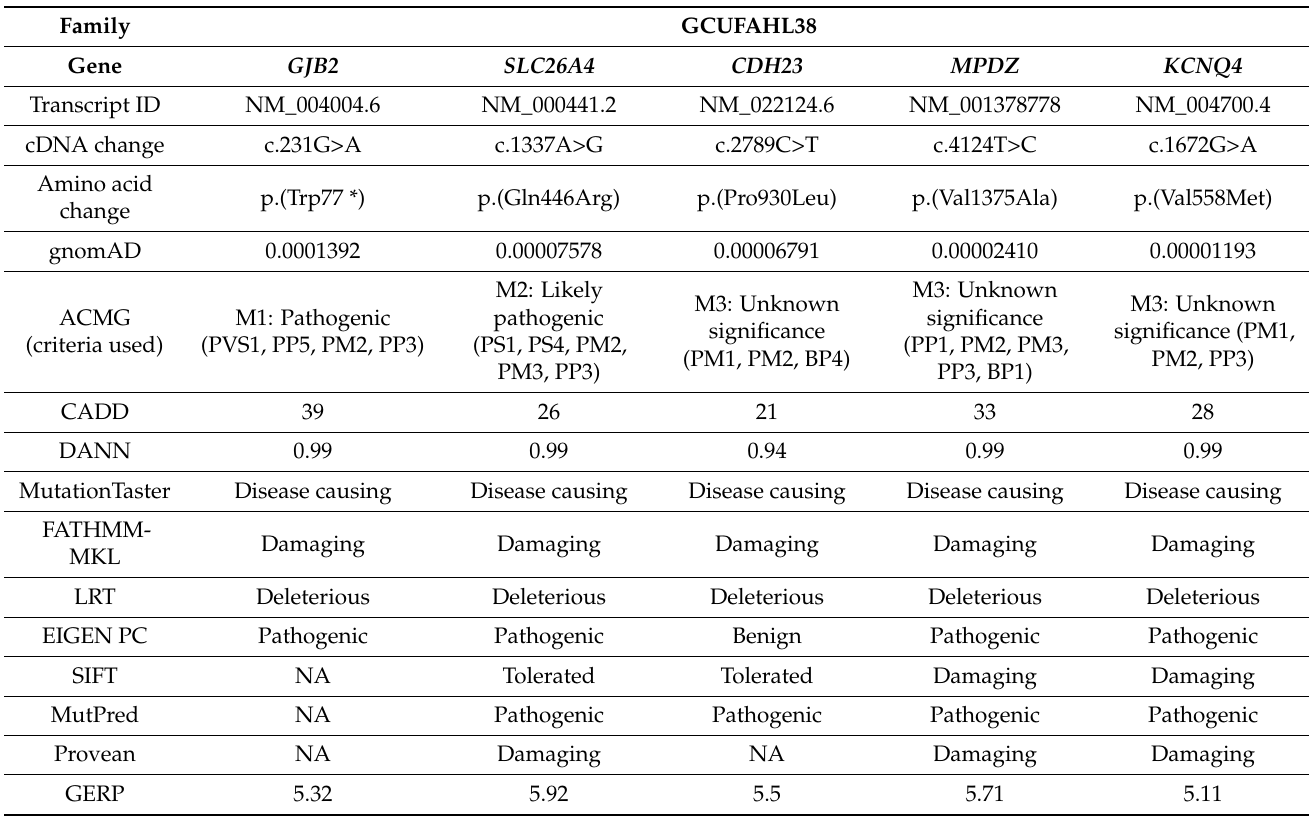
Table 2. Genes, identified variants and their ACMG classification in GCUFAHL38.